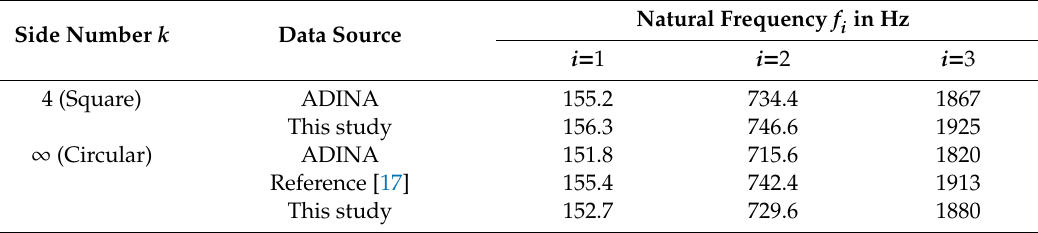
Table 2. Comparison of frequencies * f i of this study with those obtained by ADINA and references. Side Number k